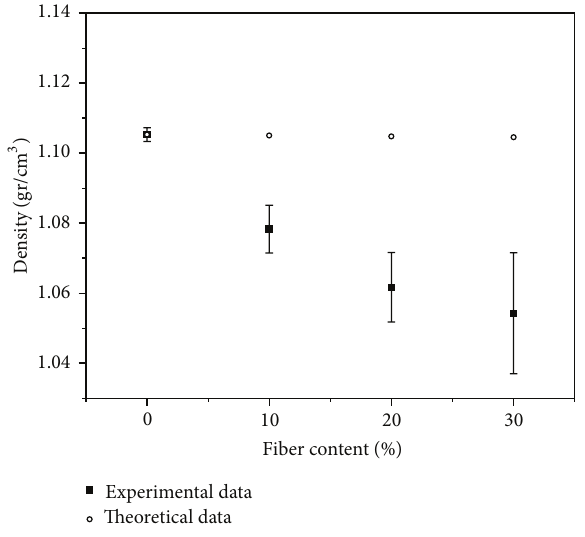
Figure 6: Density of LDPE-Al and 10, 20, and 30% fique fiber